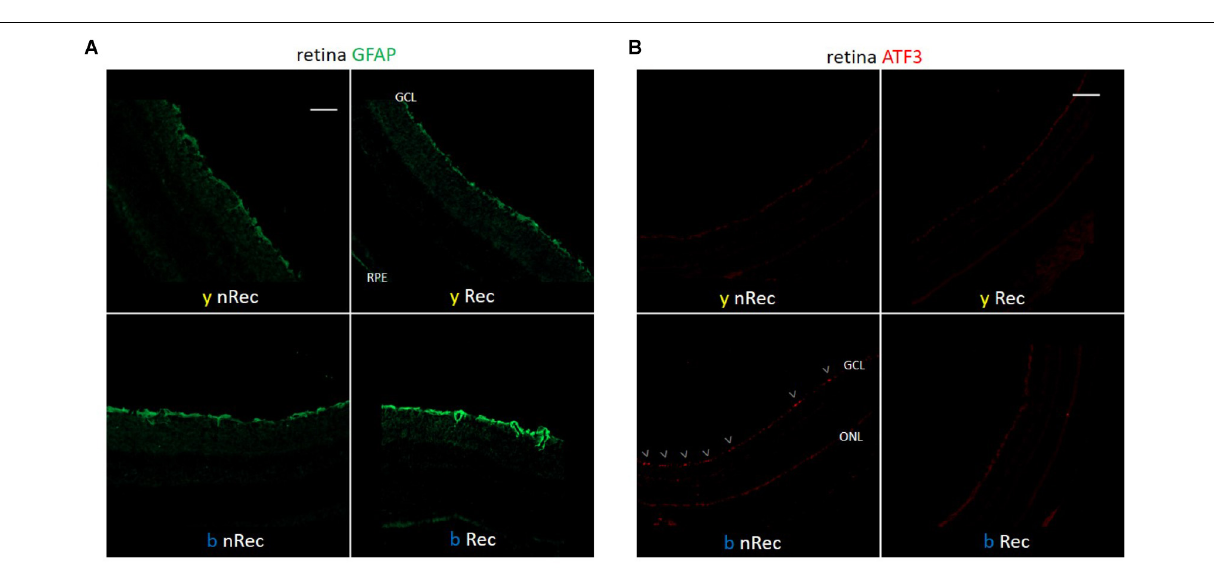
FIGURE 4 | Light-induced retinal inflammation (1). Immunohistochemistry was performed on the retinas of blue- ( b ) and yellow-exposed ( y ) mice either immediately after illumination ( nRec ) or in 3 days of recovery ( Rec ). Results of anti-GFAP (A) and anti-ATF3 ( B , immuno-activated cells are marked by arrowheads) stainings are presented. Magnification is 10 × (A,B) , scale bars correspond to 100 µ